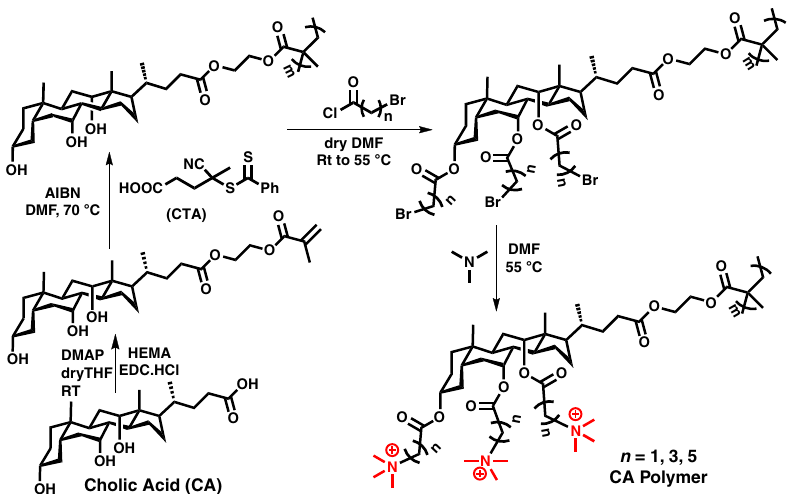
Fig. 3 Synthesis of cholic acid-containing polymers. Cholic acid (CA) converted into (2-methacryloyloxy)ethyl cholate (MAECA); RAFT polymerization of MAECA; post-polymerization modi fi cation with bromoalkanoyl chloride; quaternization with trimethyl amine